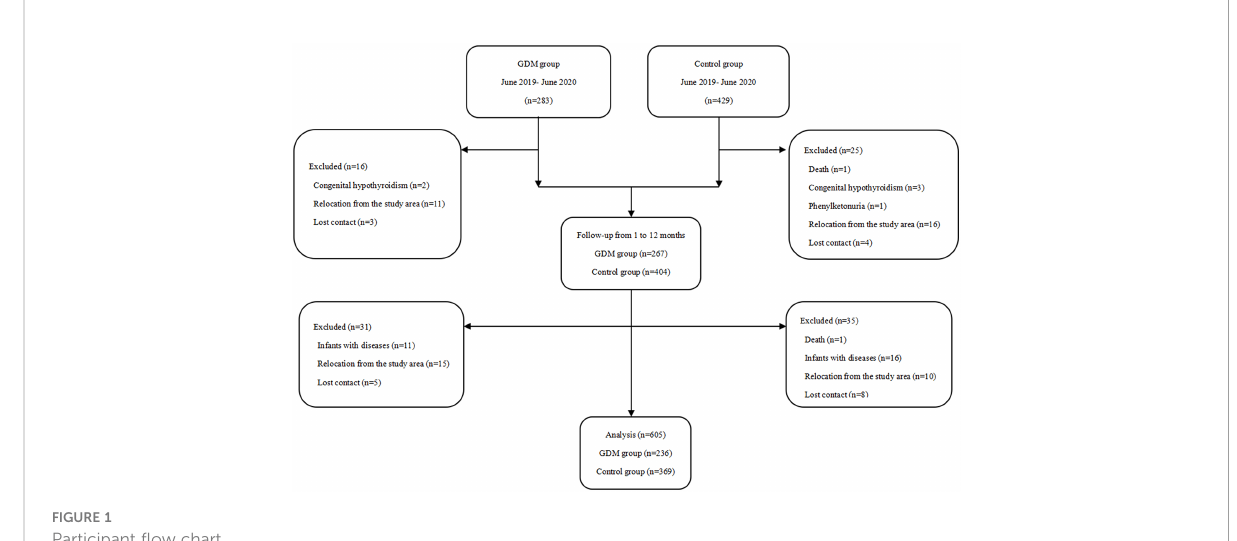
FIGURE 1 Participant fl ow